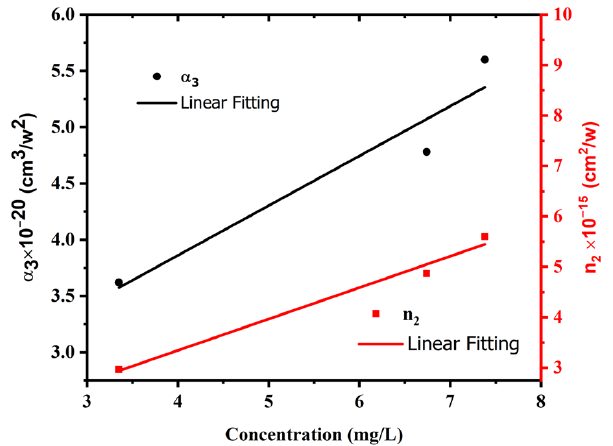
Figure 12. Dependence of α 3 and n 2 on AgNP colloid concentration at constant excitation power and wavelength of 1 W and 800 nm, respectively.